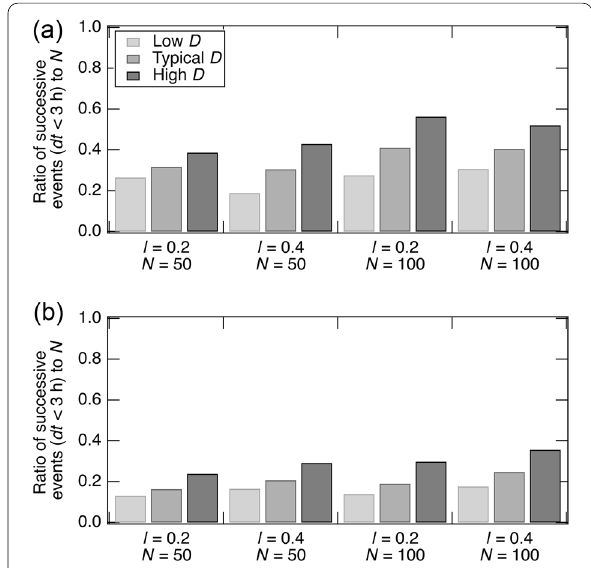
Fig. 21 Ratio of earthquakes that occurred within 3 h after another earthquake in the typical, high, and low D -value regions to N . a Area A; b area